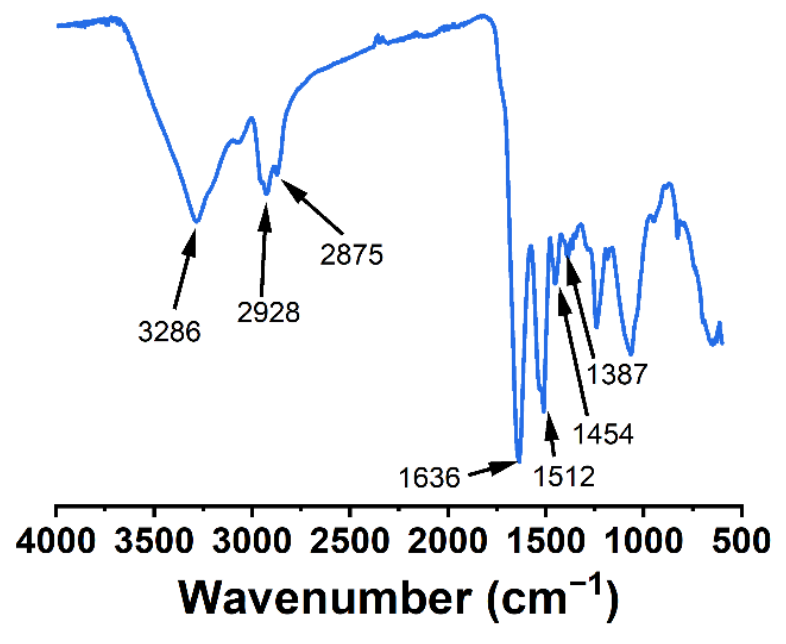
Figure 4. ATR-FTIR spectrum of the synthesized Au NPs.